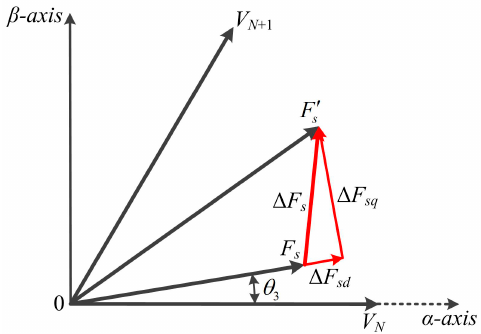
Figure 7. Analysis of error compensational effects in transient-state.